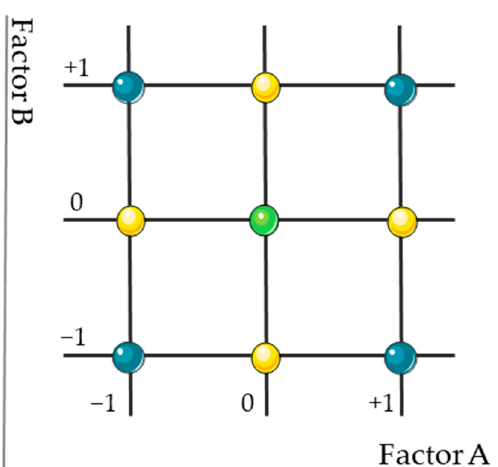
Figure 3. Face-centered central composite design (FcCCD) with a rectangular domain. Blue dots indicate the two-level factorial design, green represents the central point, and yellow points out the axial points.